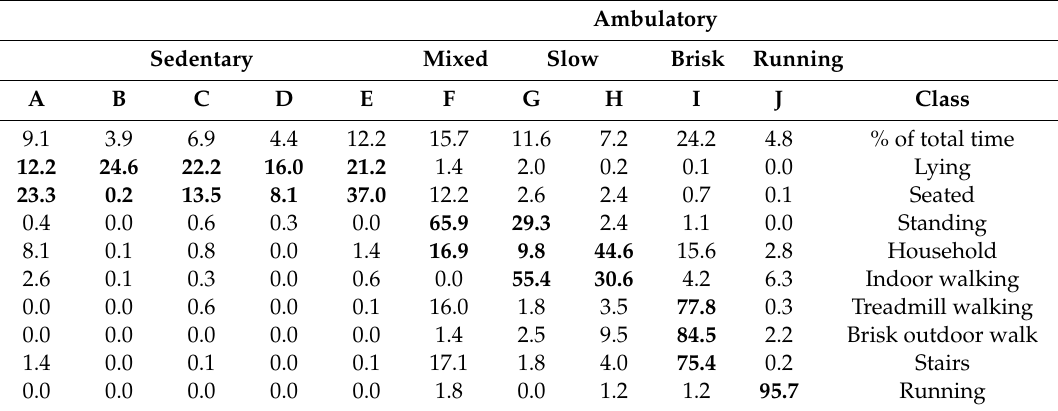
Table 3. Purity matrix (percentage of each class found within each cluster (A–J)) for the development dataset (two combined adult datasets). (Key statistics highlighted in bold) Ambulatory Sedentary Mixed Slow Brisk Running